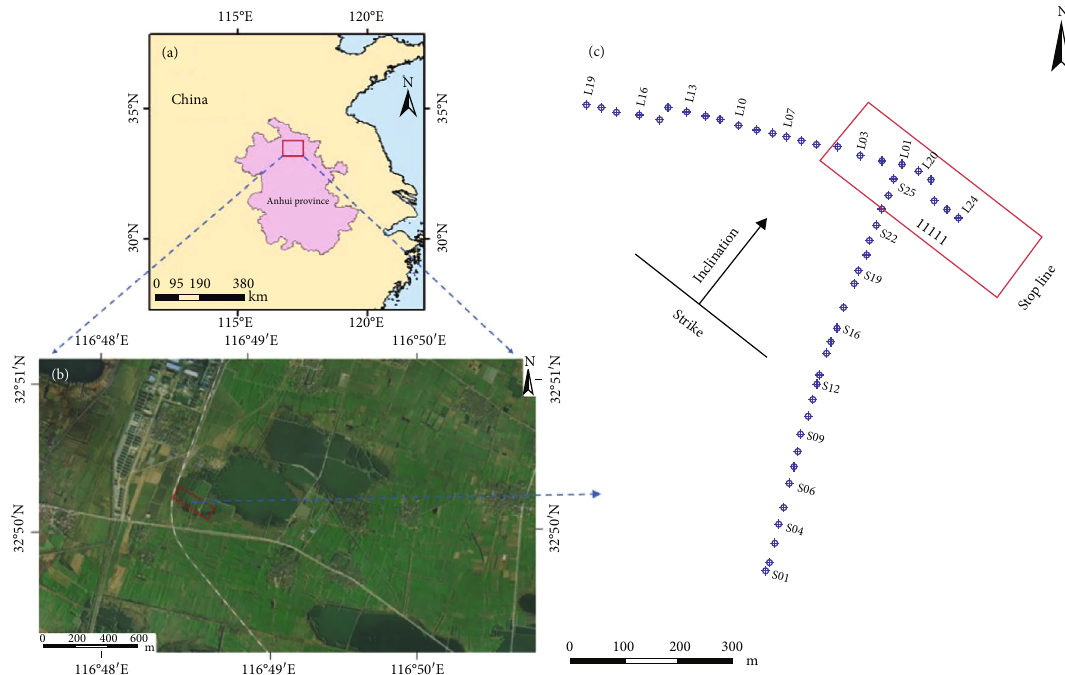
Figure 8: The location of the 11111 working face.